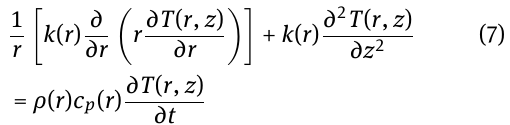
Figure 2: Nanofiller distributions along the radial direction accord- ing to the proposed